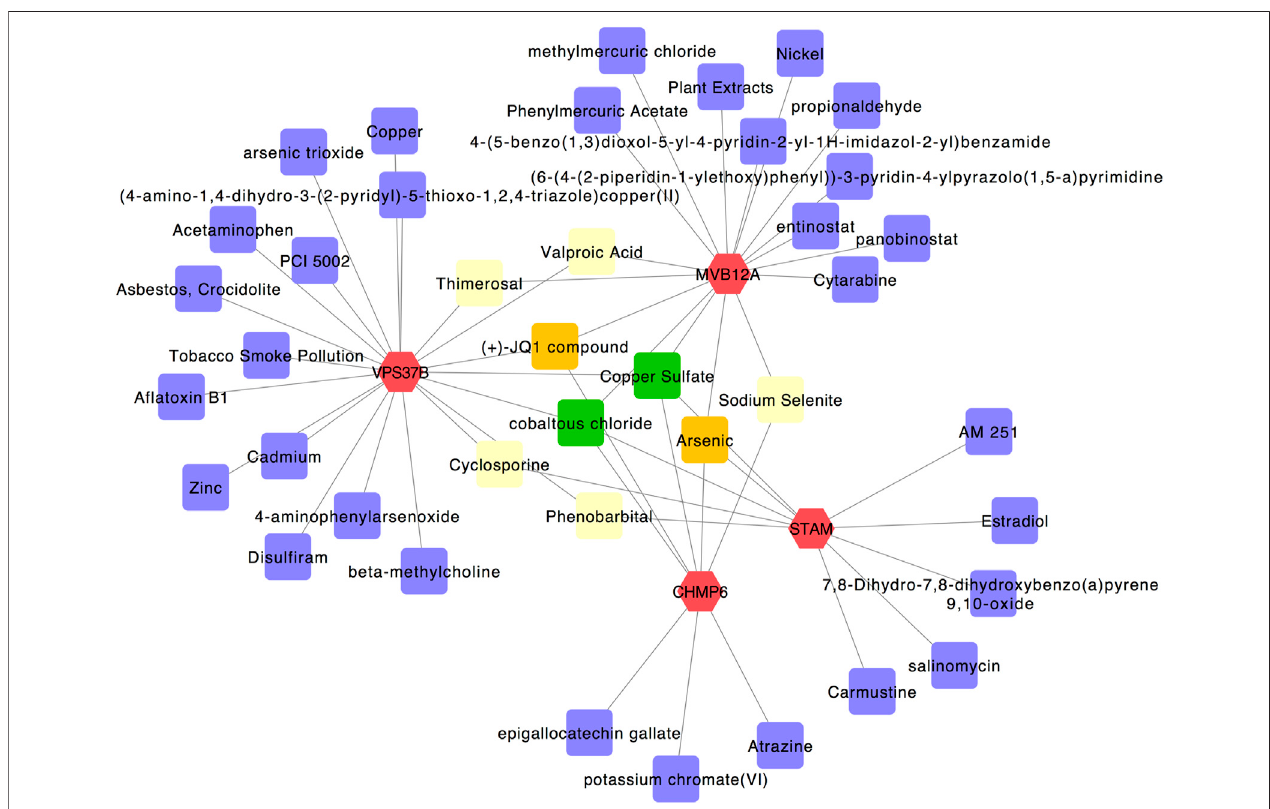
FIGURE 7 | Gene – chemical interaction network. Genes are colored in red; chemical agents are colored in purple; chemical agents targeting two genes simultaneously are shown in yellow; chemical agents targeting three genes simultaneously are shown in orange; chemical agents targeting all four genes simultaneously are shown in